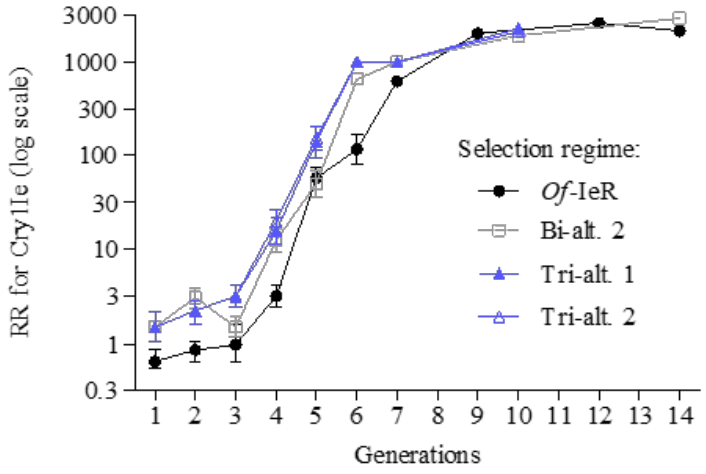
with Cry1Ab-Cry1F-Cry1Ie in alternation. Tri-alt.2, selected with Cry1Ab-Cry1F-Cry1Ie-Cry1F in